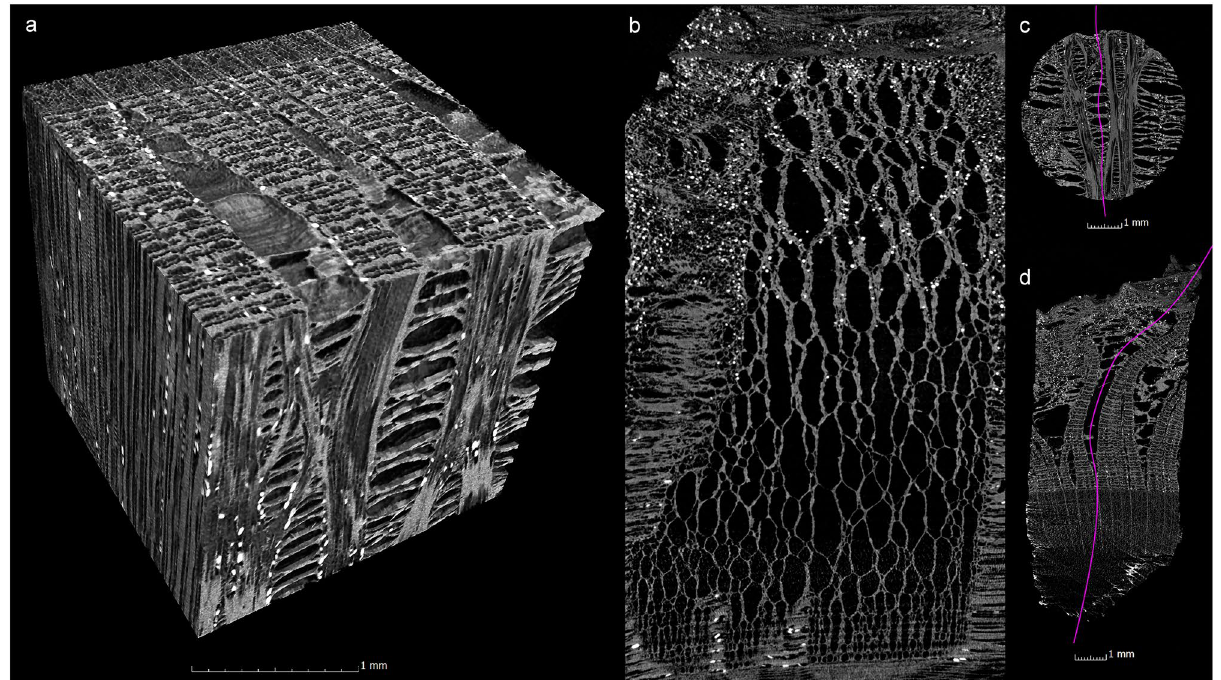
Figure 4. Three-dimensional µCT representation ( a ) and radial section along a phloem ray ( b ) in the bark of lime (sample 1). The radial plane of view of the phloem ray ( b ) is illustrated by the pink line in the tangential ( c ) and transversal ( d )